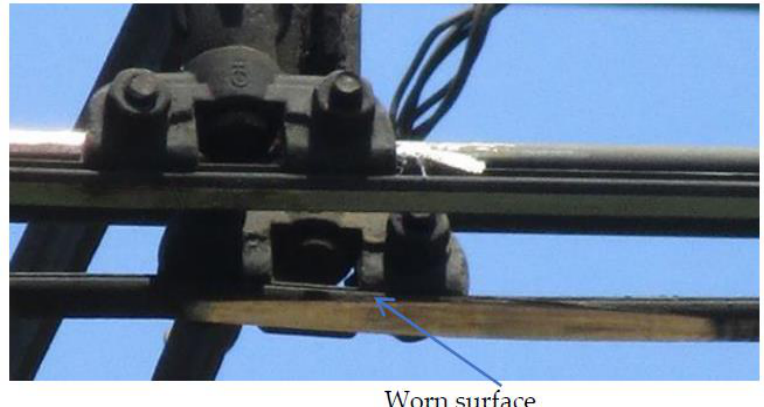
Figure 1. Worn-out area on a surface of a contact wire.